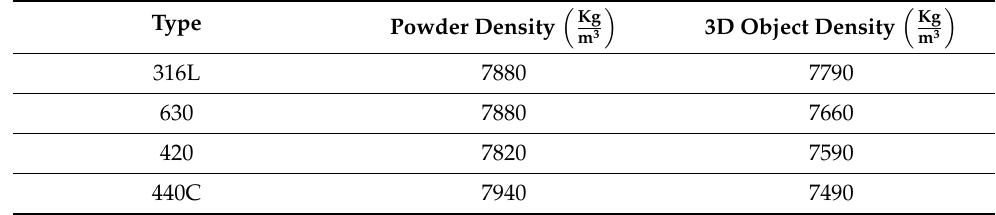
Table 3. Density comparison between powder and 3D